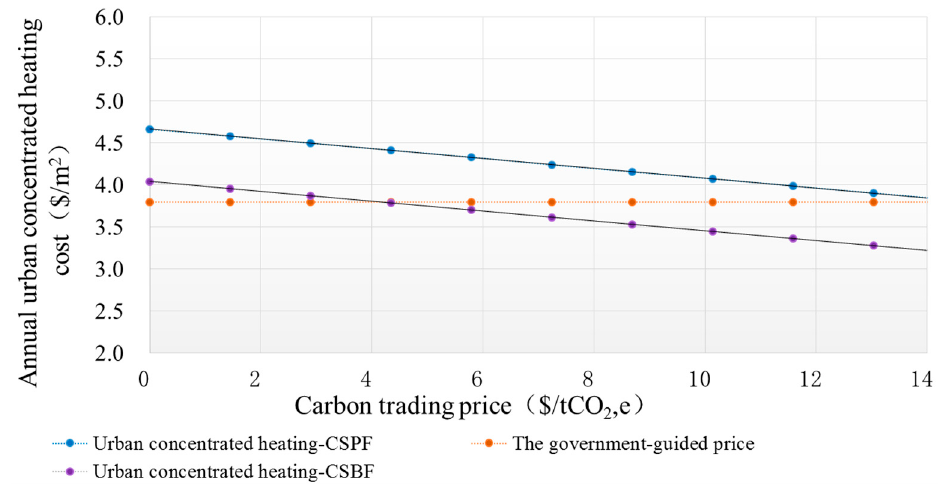
Figure 10. Influence of carbon trading on the economic performance of CSDF for urban concentrated heating.